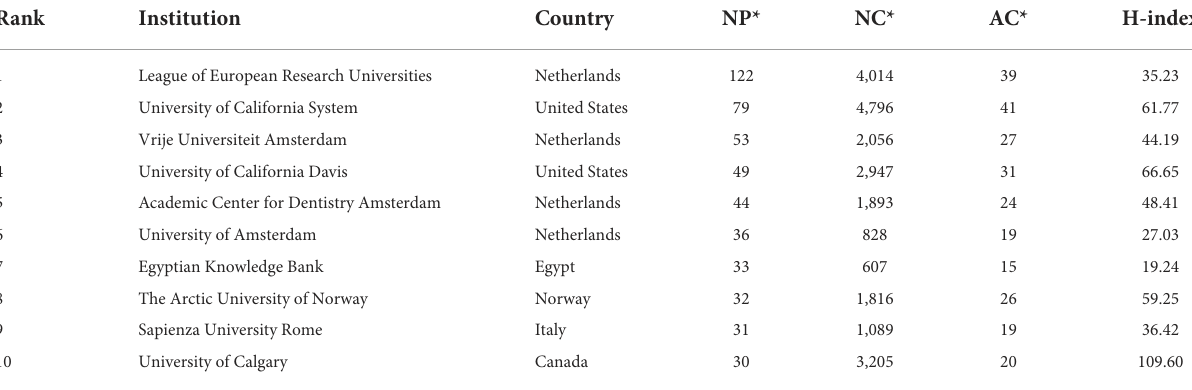
TABLE 2 Topmost 10 productive institutions in the field of LF antibacterial research.